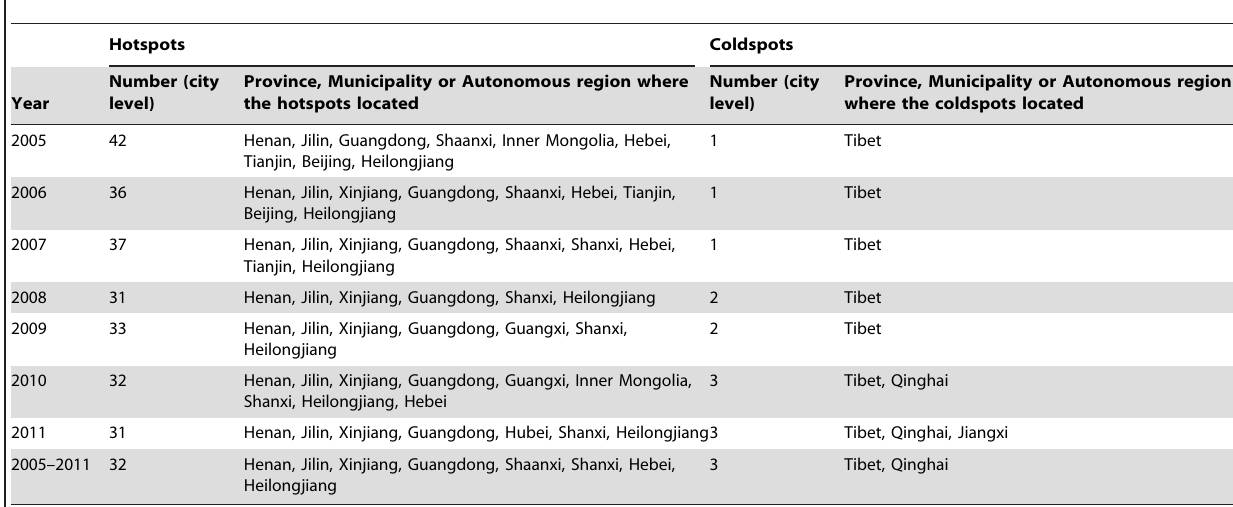
Table 2. Distribution of Hotspots and Coldspots of HCV infection in China from 2005 to 2011.